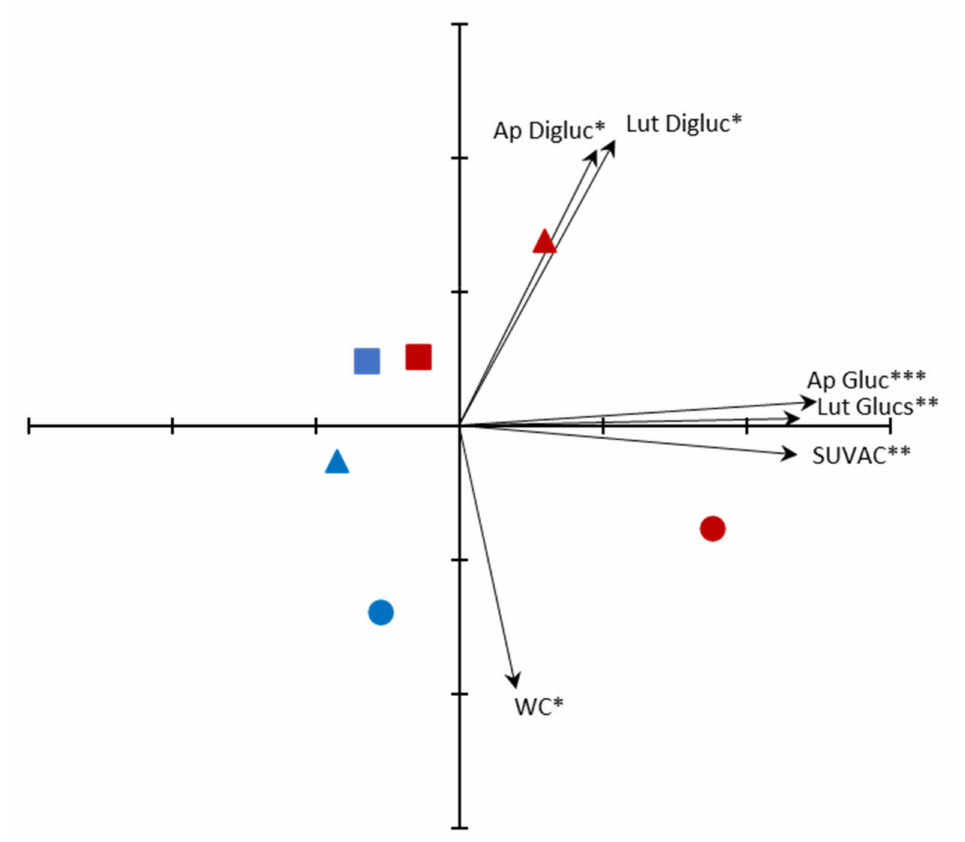
Figure 3. Ordination, through Principal Components Analysis (PCA), of Marchantia polymorpha subsp. ruderalis Tak-1 samples exposed to two different radiation regimes (P, only PAR, blue; PAB, PAR + UV-A + UV-B, red) starting from three different developmental stages: gemmae (G, circles), one-month thalli (T1, triangles), and two-month thalli (T2, squares). Significant loading factors for the positive and negative parts of each principal component (PC), together with their corresponding significance levels, are shown as arrows. Significance of each loading factor is denoted by asterisks (***, p < 0.001; **, p < 0.01; *, p < 0.05). PC1 is the horizontal one, and PC2 is the vertical one. Each tic-mark on the PCs represents one unit. Ap Digluc, apigenin 7,4 (cid:48) -di- O -glucuronide. Ap Gluc, apigenin 7- O -glucuronide. Lut Digluc, luteolin 7,3 (cid:48) -di- O -glucuronide. Lut Glucs, sum of luteolin 3 (cid:48) - O -glucuronide, luteolin 4 (cid:48) - O -glucuronide and luteolin 7- O -glucuronide. SUVAC, bulk level of methanol-soluble UV-absorbing compounds. WC, water